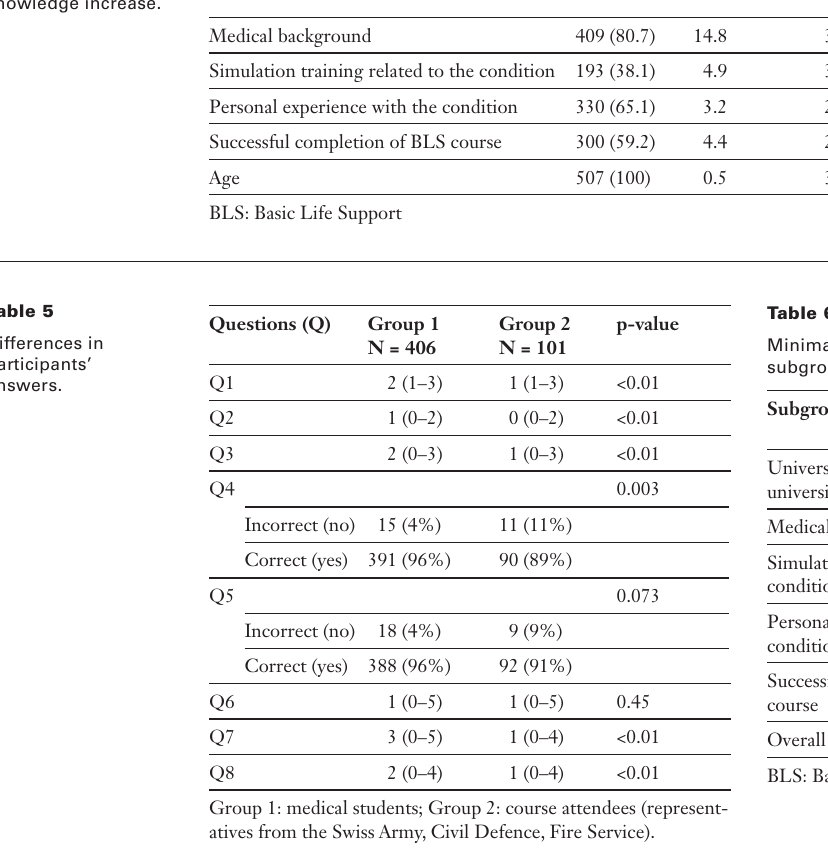
Influence of different factors on minimal knowledge increase.